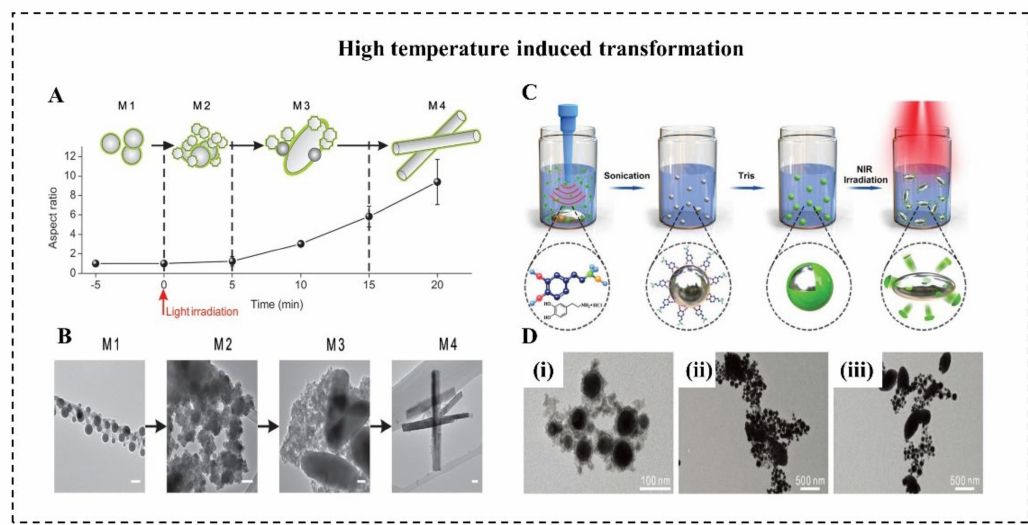
Figure 5. High-temperature-induced morphological transformation. ( A ) Schematic illustration and ( B ) representative TEM images (Scale bars: 100 nm) in the aspect ratio of the LMNPs coated with graphene quantum dots (GQDs) over light irradiation time [20]. ( C ) Schematic illustration of high-temperature-induced morphological transformation polydopamine (PDA)-coated LM microdroplets (LMMDs) [21]. ( D ) TEM images of PDA-coated LMMDs irradiated with NIR laser for ( i ) 0 min, ( ii ) 10 min, and ( iii ) 20 min